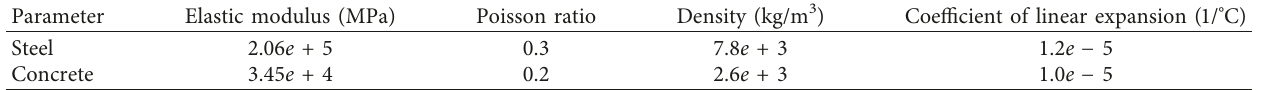
Table 1: Mechanical parameters used in the analyses.